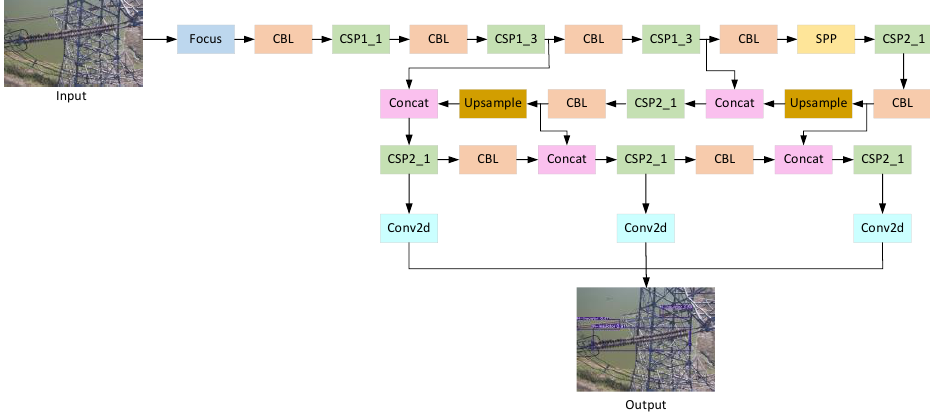
Figure 1. Original YOLOv5 network model detection block diagram.